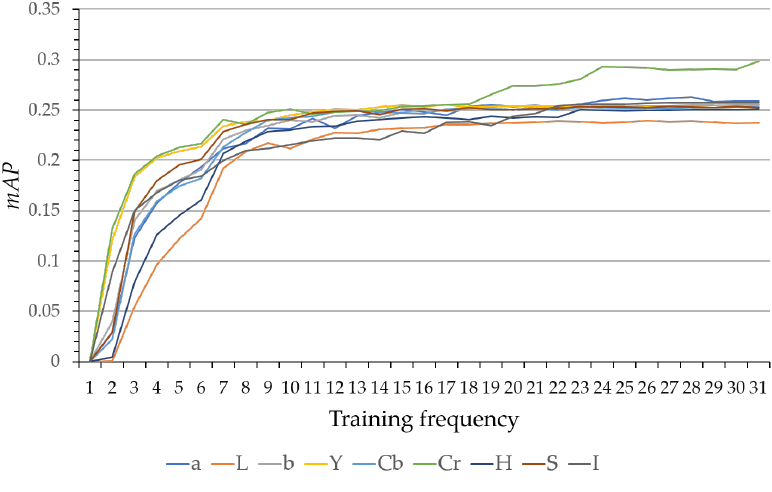
Figure 8. Performance results of single channel data with the YOLOv5s model.